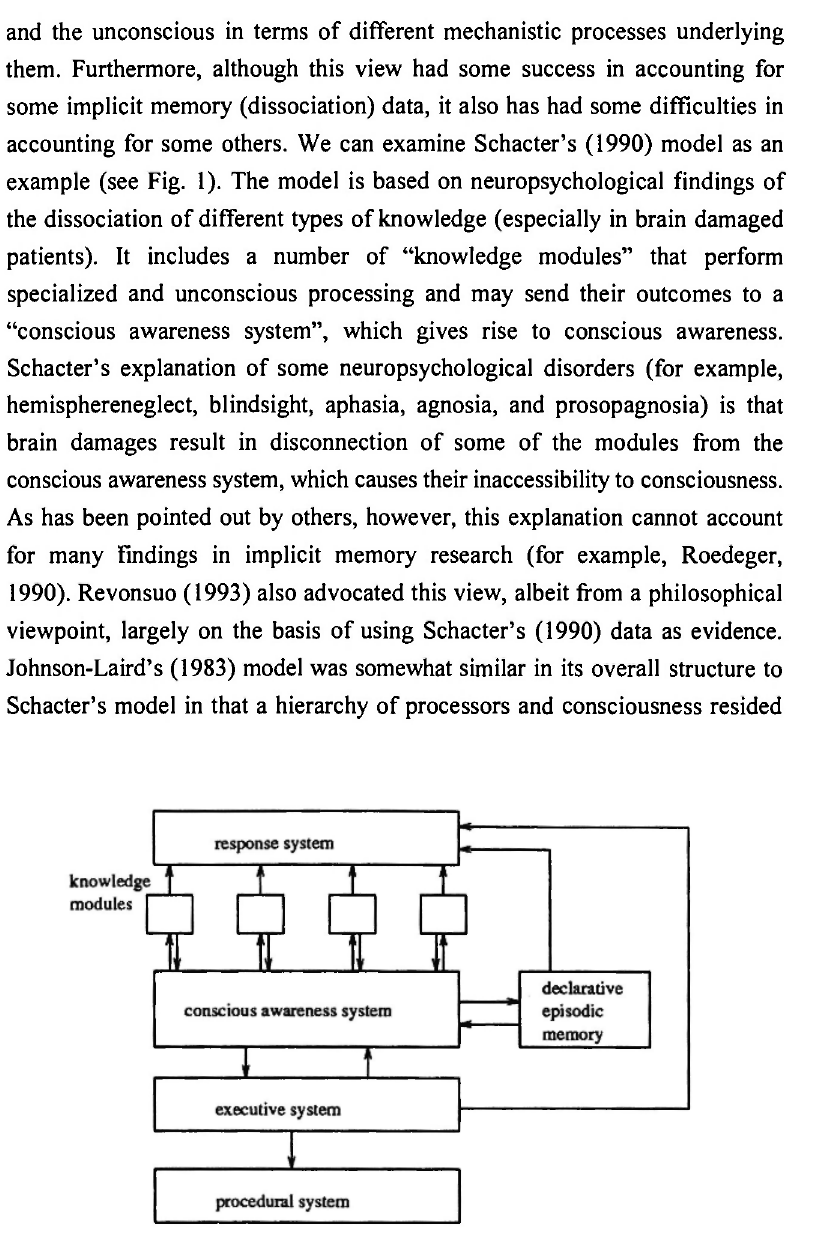
Schacter's model of consciousness